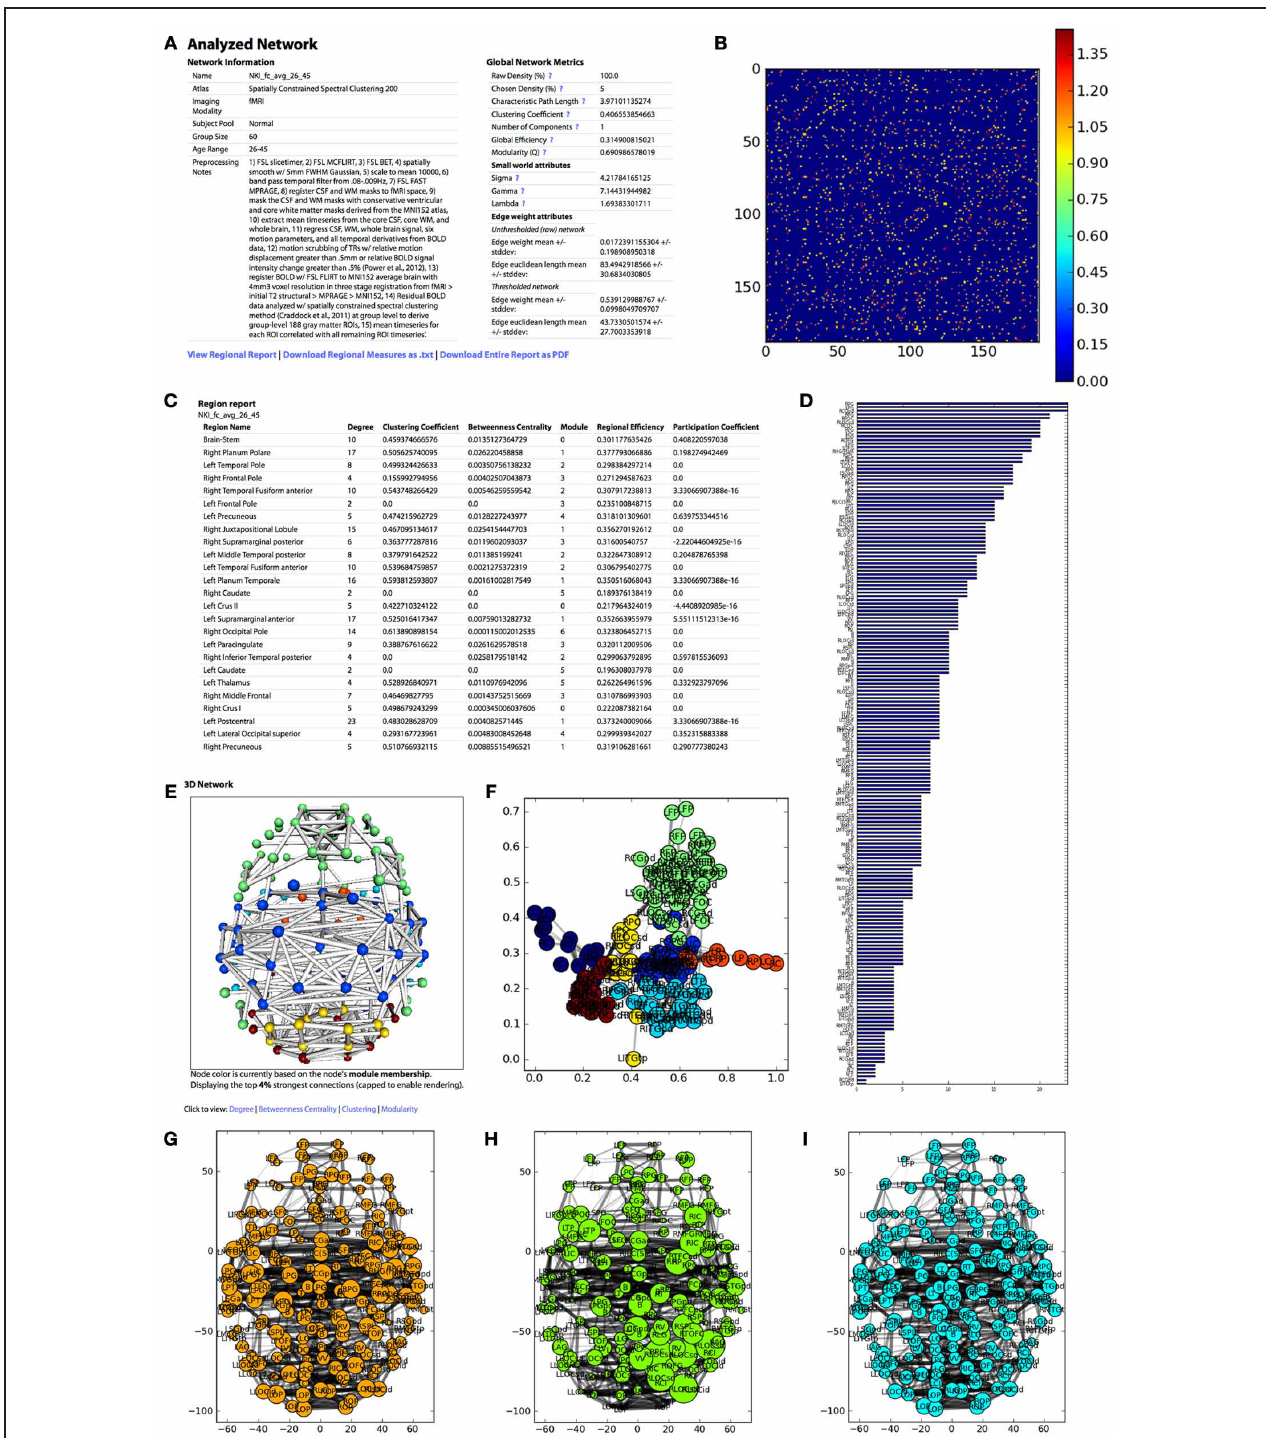
FIGURE 4 | The appearance of the UMCD report based on the analysis of the NKI fcMRI group-average network, thresholded at 5% with weighted edges. (A) The meta-information on the network and the global network metrics, including basic edge statistics, graph theory measures, and edge length measures, (B) the CM after thresholding, (C) the region report, listing the graph theory measures for each node, (D) the bar plot of node degree for each node, (E) the interactive 3D network rendering from